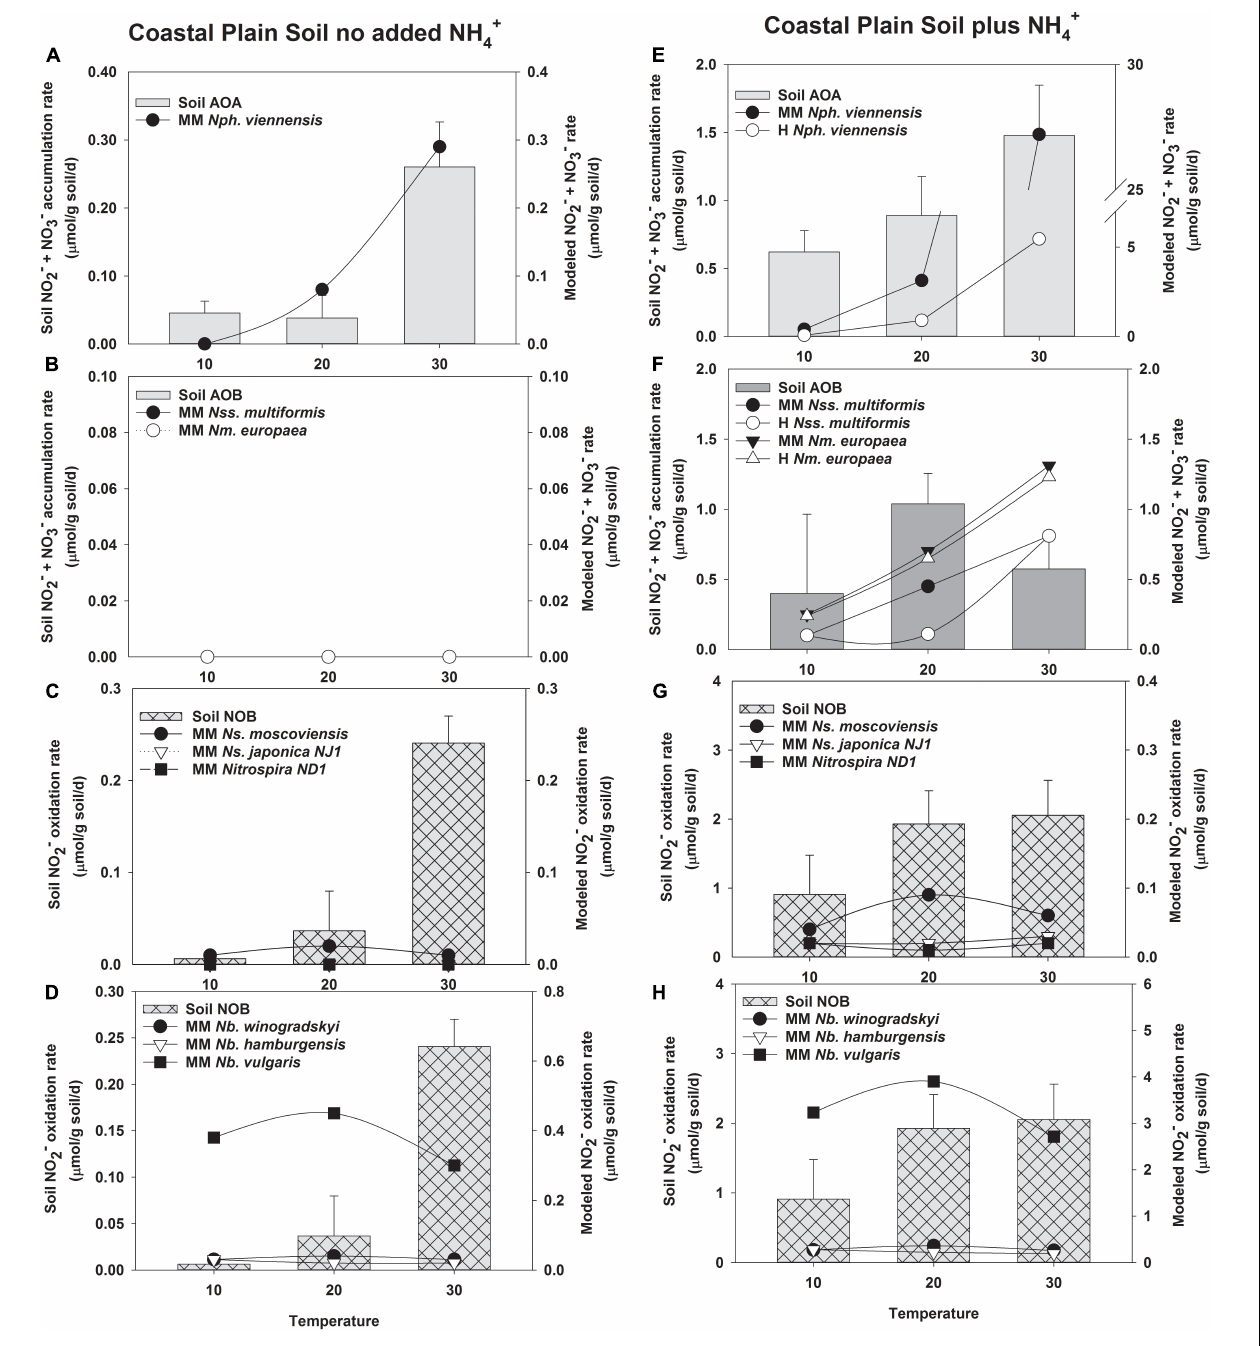
FIGURE 3 | Comparison of the potential response of AOA, AOB, and NOB cultures evaluated with the response of soil nitrifiers in short-term (24 h) incubations of Coastal Plain soil without no NH 4 + addition (A–D) , and with NH 4 + addition (5 µ mol/g soil, E–H) . The soil nitrifier response measured during the incubations is indicated by the bars corresponding to the left y -axis, and the response modeled using the kinetics of nitrifier cultures determined in this study ( Supplementary Table 5 ) is indicated by the symbols corresponding to the right y -axis. Individual nitrifier names are preceded by either MM or Haldane (H) to indicate that MM or H parameters, respectively, were used to calculate the potential rates of